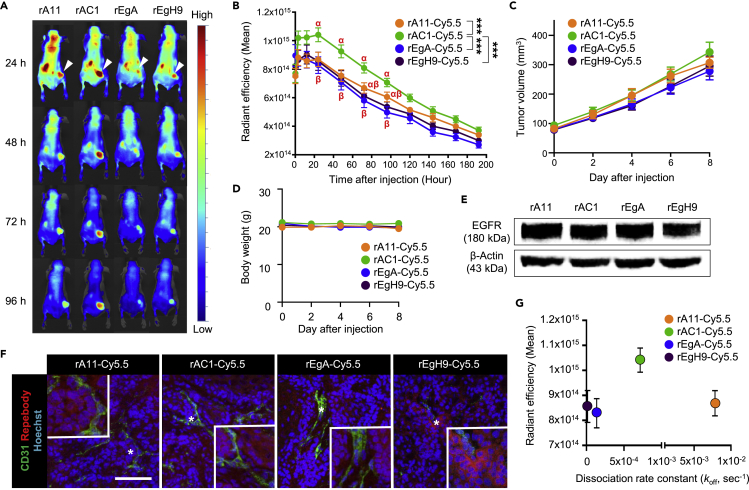
In vivo analysis of tumor targeting and localization of Cy5.5-conjugated repebodies(A and B) (A) Representative whole-body biodistribution images and (B) the mean radiant intensities measured in the tumor at different time points after intravenous injection of all repebody-Cy5.5 conjugates were administered in the A431 tumor-bearing mice. A clear increase in the accumulation of rAC1-Cy5.5 conjugates was observed after 6 h. White arrowheads in the images at 24 h indicate the location of the subcutaneous tumor. ∗∗∗ indicates p < 0.001, calculated by one-way ANOVA. Data are the mean ± SEM (n = 10 mice per rAC1-Cy5.5 conjugate-treated group and n = 11 mice per the other conjugate-treated groups) and mean values with the different alphabet (α, β) represent the different pairs of values (p < 0.05).(C) Growth of the A431 tumor in mice injected with the conjugated repebodies having different binding affinity. There was a negligible difference in tumor volume among the four Cy5.5-labeled repebodies. Data represent the mean ± SEM.(D) Kinetics of body weight in tumor-bearing mice treated with repebodies. Data are the mean ± SEM.(E) Western blot for the ex vivo A431 tumor from the repebody-treated groups for EGFR. β-Actin was used as the loading control.(F) Immunostaining of repebody (red) and CD31 (green) in the A431 tumors grown in mice. CD31 is used as a vascular marker. Nuclei are shown in blue with Hoechst 33342 counterstaining. Compared with the other three repebody-Cy5.5 conjugates that penetrated and distributed through the entire tumor tissues at 6 h after injection, rEgH9-Cy5.5 conjugates showed a restricted localization to the perivascular space. The inset shows magnified regions indicated with an asterisk (∗). Scale bar, 100 μm.(G) The mean radiation efficiency (20 h after injection) of Cy5.5-conjugated repebodies were plotted with respect to the dissociation rate constants (koff) for EGFR. Data represent the mean ± SEM.